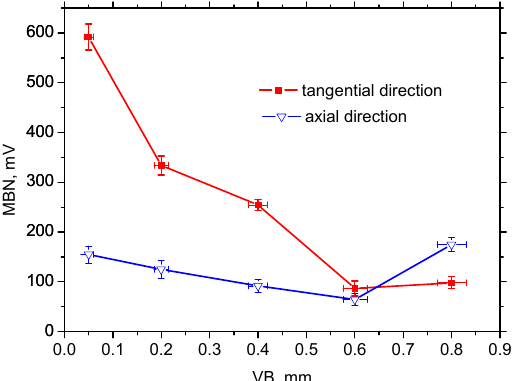
Figure 13. MBN for tangential and axial directions, MBN for HT surface 100 mV.